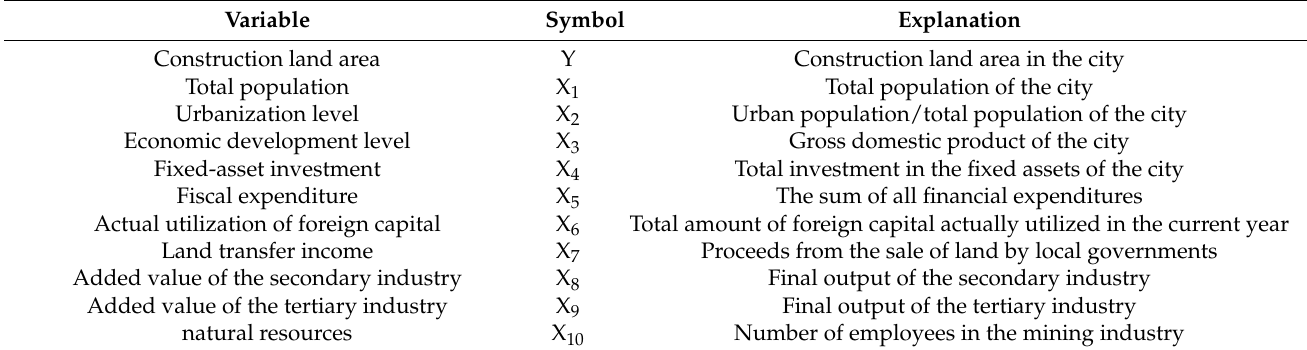
Table 3. Observation index of driving factor analysis of CLE in RBCs.